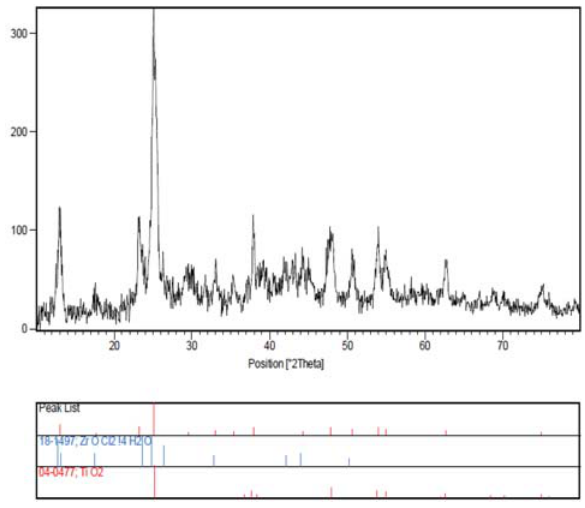
Figure 1. The XRD pattern of ZrOCl